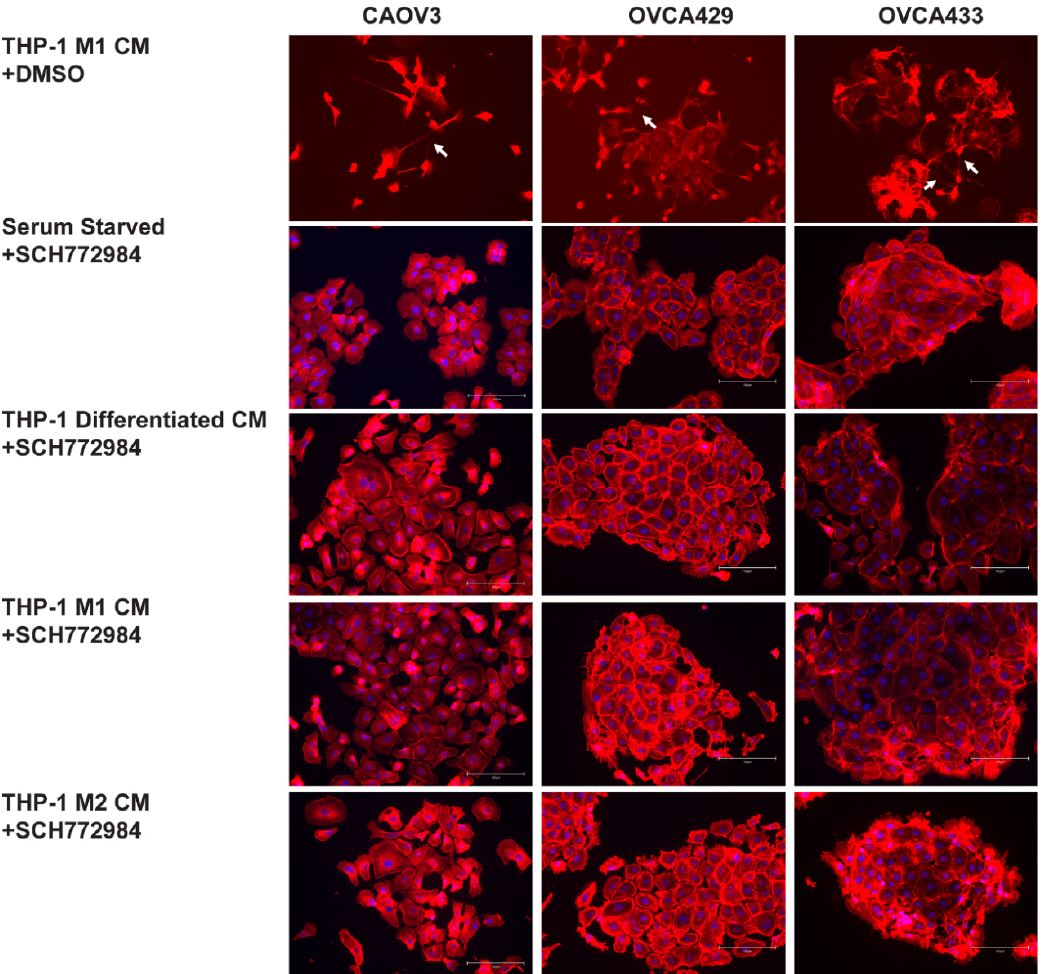
Figure 6. Membrane protrusions induction by macrophage conditioned media requires ERK activity. To assess if inhibition of ERK activity can prevent TnT formation in OCCs treated with macrophages, conditioned media (CM), CAOV3, OVCA429, and OVCA433 cells were serum starved for 24 h and then treated with conditioned media from differentiated THP-1, M1, and M2 macrophages in the presence of the ERK inhibitor SCH772984 for an additional 24 h. The top row depicts OCCs treated with M1 CM and DMASO, which results in TnTs and altered morphology (as seen in Figure 3). Cells were stained with Texas Red Phalloidin to visualize F-actin based structures and DAPI (blue). Images are representative of 3 independent experiments. 20X original magnification. Scale bar = 150 µm.